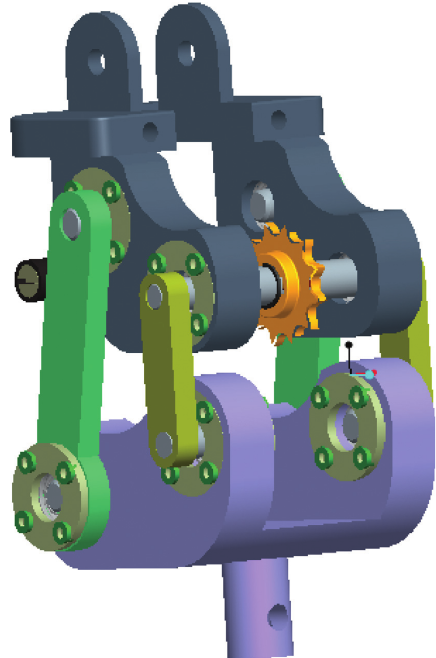
Figure 1: The structure of the four-bar knee